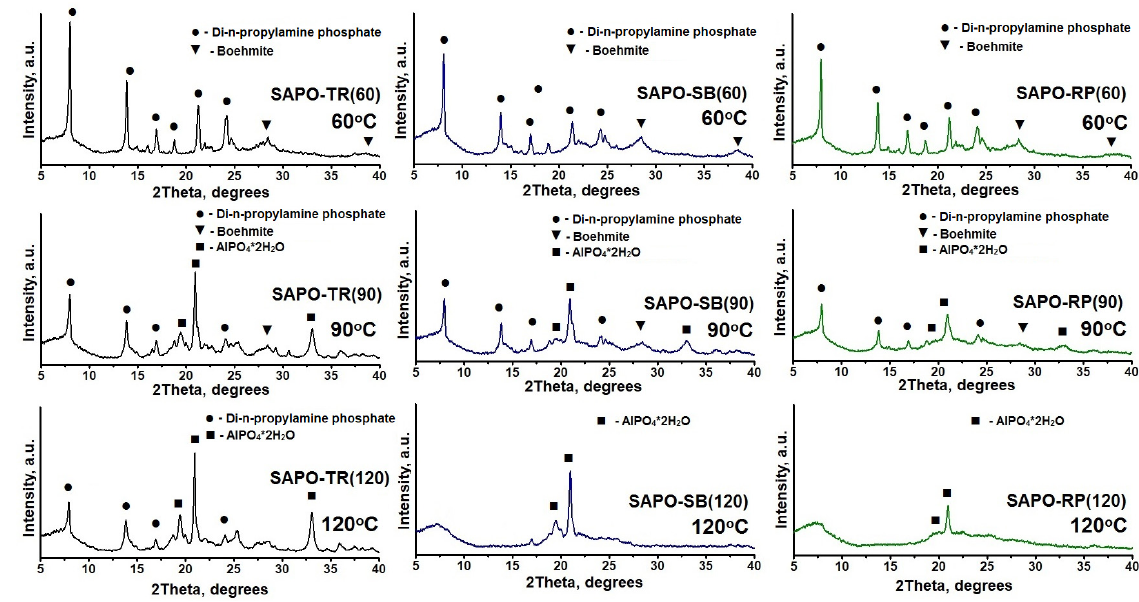
Figure 6. X-ray patterns of aged initial gels at 60 to 120 °C.